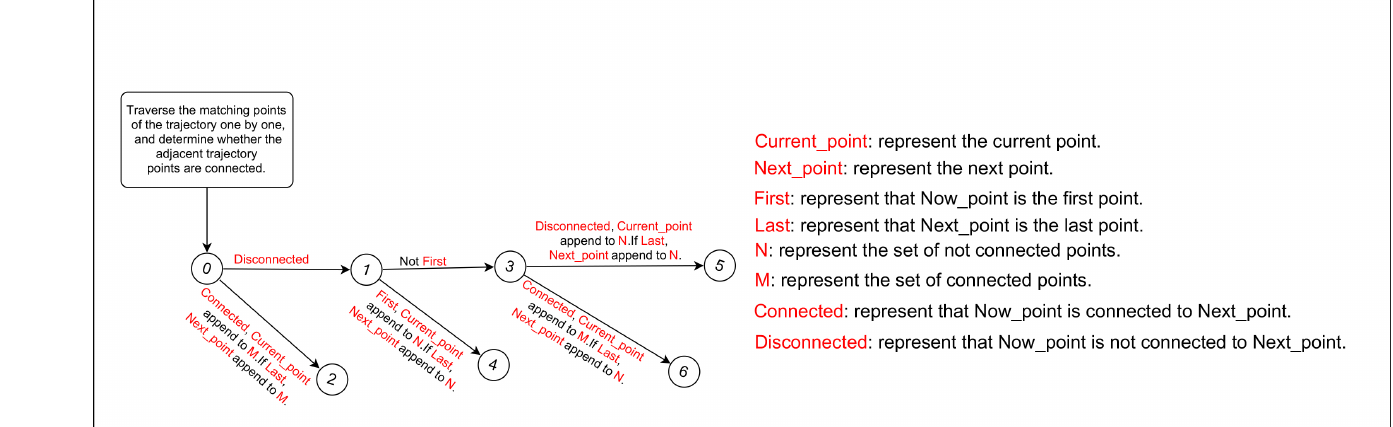
Figure 5. Algorithm of problematic road segment region extraction. The arrows indicate the execution process of the algorithm. The nodes indicate the execution steps of the